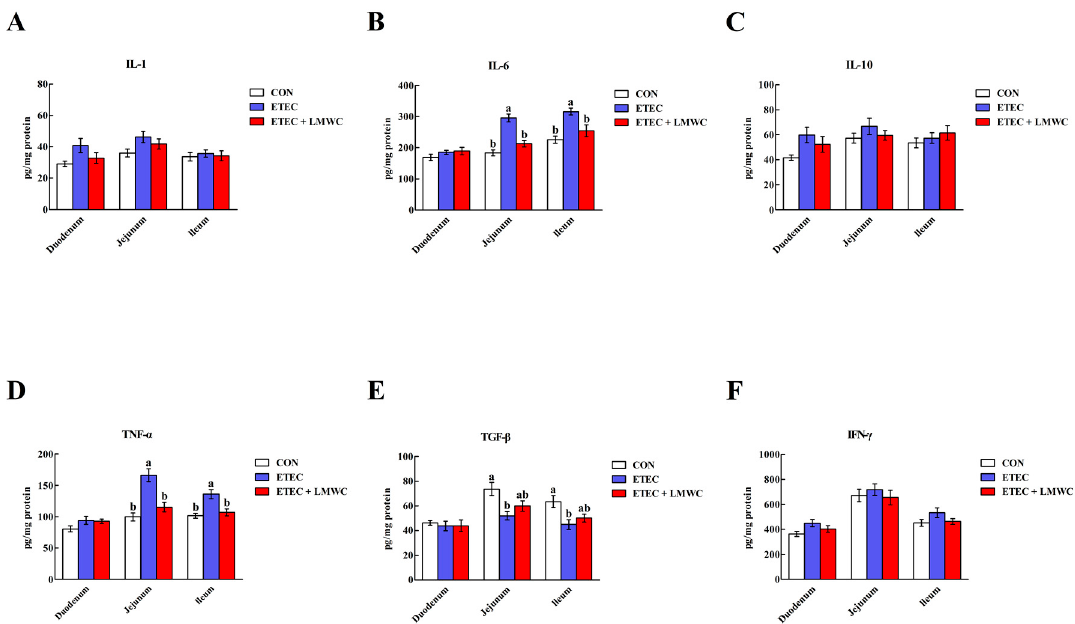
Figure 4. E ff ects of low-molecular-weight chitosan on the intestinal cytokine contents of weaned pigs challenged with enterotoxigenic Escherichia coli . ( A ) IL-1, interleukin-1. ( B ) IL-6, interleukin-6. ( C ) IL-10, interleukin-10. ( D ) TNF- α , tumour necrosis factor- α . ( E ) TGF- β , transforming growth factor- β . ( F ) IFN- γ , interferon- γ . a, b Means with di ff erent letters on vertical bars indicate significant di ff erences ( P < 0.05). Values are means ( n = 8 pigs / treatment), with standard errors represented by vertical bars. CON: non-infected control (pigs received the basal diet and infused with sterilised Luria–Bertani culture); ETEC: ETEC-infected control (pigs received the basal diet and infused with enterotoxigenic Escherichia coli ); ETEC + LMWC: pigs received the basal diet supplemented with 100 mg / kg low-molecular-weight chitosan and infused with enterotoxigenic Escherichia coli .